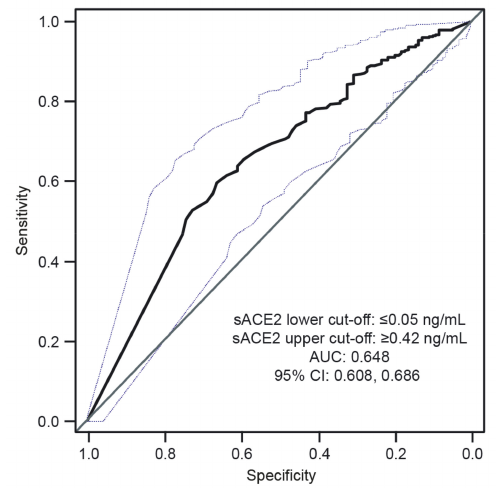
Figure 3. ROC curve analysis used to calculate lower and upper cut-off values of sACE2 for the prediction of hospitalization in patients with SARS-CoV-2. Blue dotted lines = upper and lower limits of the 95% CI for